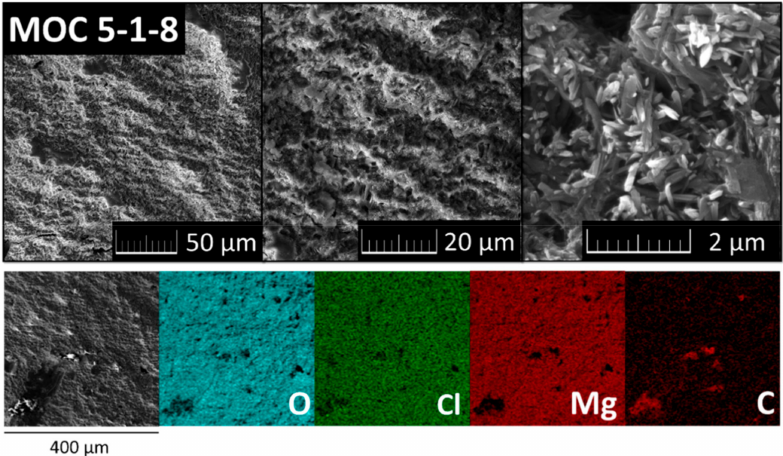
Figure 4. Scanning electron microscopy micrographs and energy-dispersive X-ray spectroscopy (EDS) elemental maps of MOC 5-1-8.